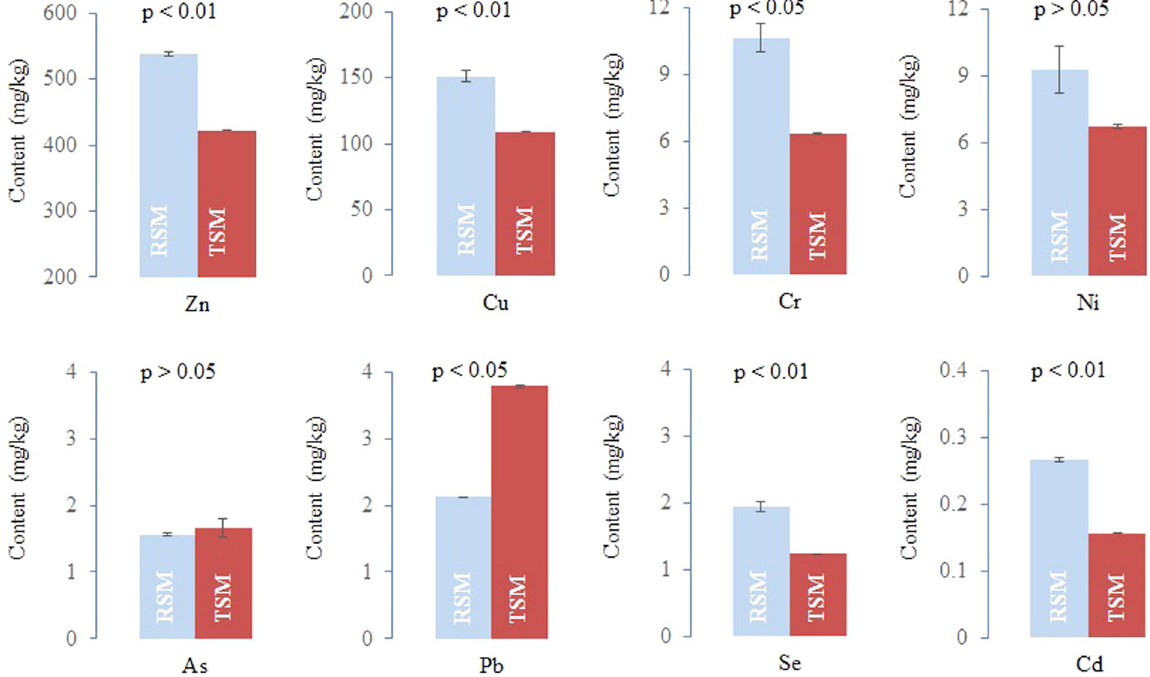
Figure 1. Heavy metal levels in swine manure before and after maggot conversion. RSM means raw swine manure; TSM means maggot-treated swine manure; data are presented as the means ± SEM (n = 3); the p value represents the significant differences; and values were analysed by Student’s t-test.